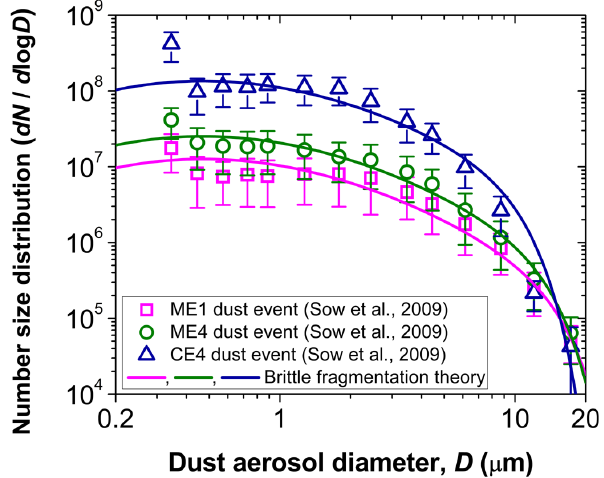
Fig. 3. Measurements by Sow et al. (2009) of the emitted dust PSD for three different dust events are reproduced by varying the side crack propagation length λ in the brittle fragmentation the- ory of dust emission (Kok, 2011). Values for λ of 15.1, 13.5, and 10.3µm were obtained for respectively the ME1, ME4, and CE4 dust events by using a least-squares fitting procedure with Eq. (5) in Kok (2011). The fully-dispersed soil PSD parameters in the brittle fragmentation theory were obtained from Kok (2011).